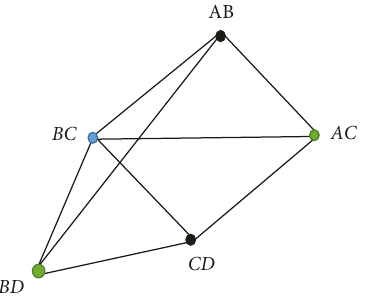
Figure 3: The colored graph of the example 2.